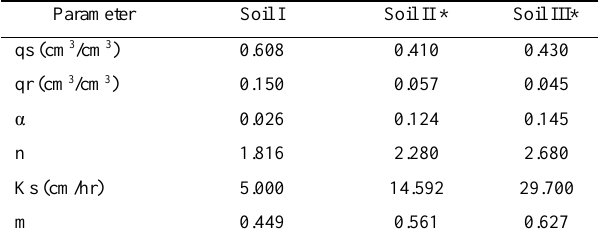
Fig. 8 Soil water retention curve